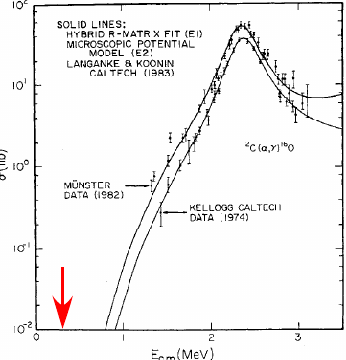
Figure 8.20: The measured capture probability (in Figure 15: The measured capture probability (in units units of nano-barns) by the Munster (1982) and the of nano-barns) by the Munster (1982) and the Kel- Kellogg (1974) laboratories. The arrow marks the logg(1974) laboratories. The arrow marks the energy energy range at which the reaction take place in stars. The continuous lines are the theoretical fit range at which the reaction takes place in stars. The by Langanke and Koonin 1983 and it includes the continuous lines are the theoretical fit by Langanke & e↵ect of the resonance. Koonin 1983 and it includes the effect of the